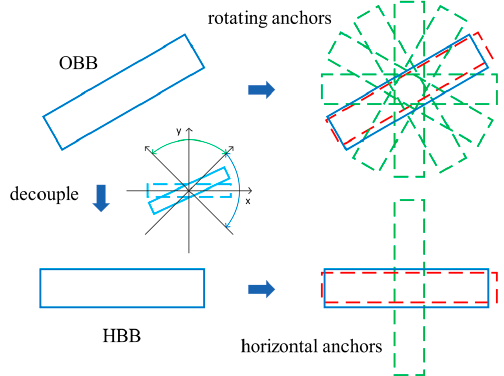
Figure 3. Rotation-decoupled matching strategy versus the strategy based on oriented anchors. The red bounding box indicates the matched anchor. bounding box indicates the matched